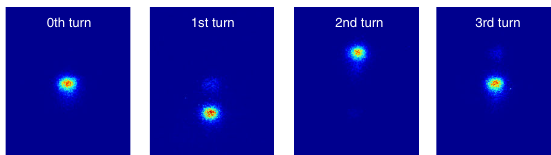
FIG. 10. A sequence of beam images at synchrotron diagnostic beam line 3.1 measured with a fast gated CCD camera at different turns after the first